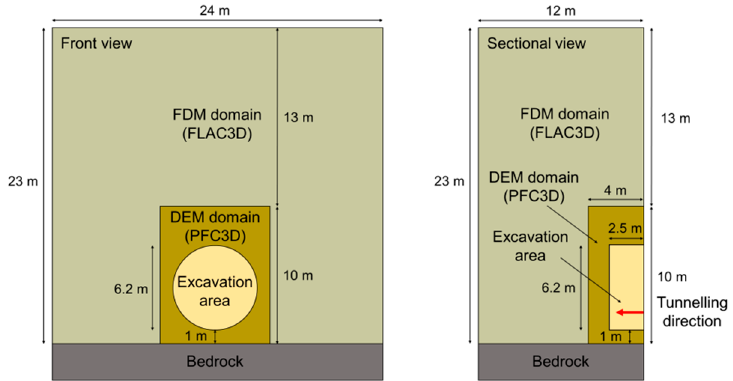
Figure 1. Schematic drawing of the numerical model for EPB shield tunnelling simulation.